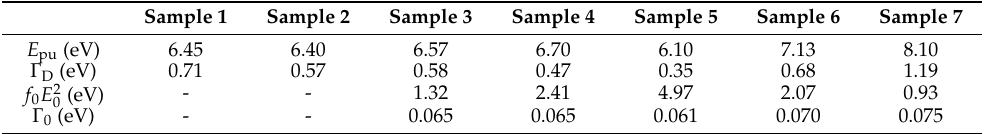
Table 3. Values of all parameters that describe the dielectric function ε for all the samples in the range of 800 nm–20 µ